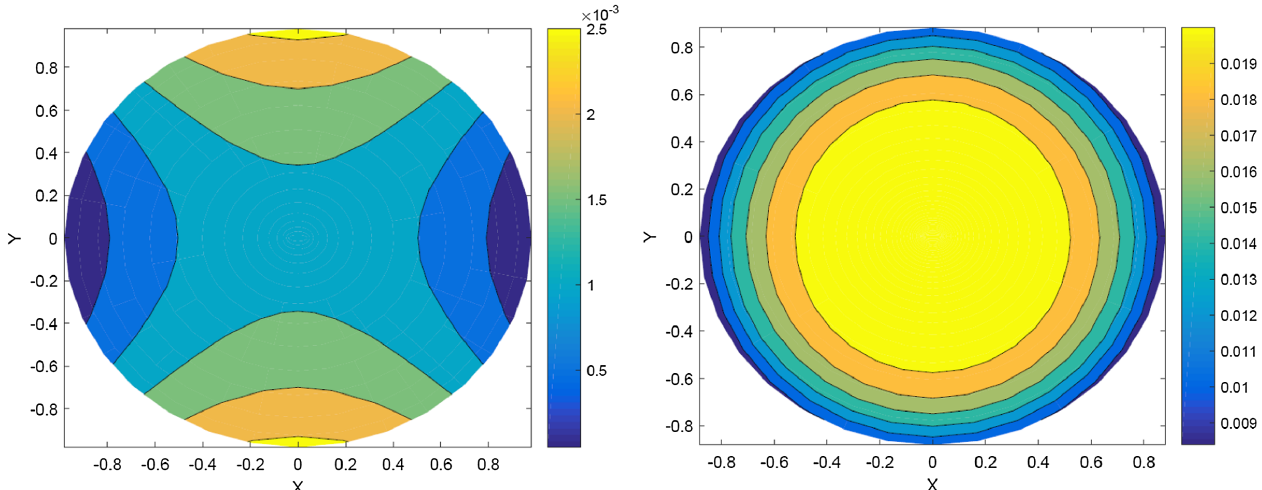
FIG. 3. Relative electric potential error from the pseudospectral method (left) and from the second-order finite difference method (right) inside a nearly round conducting